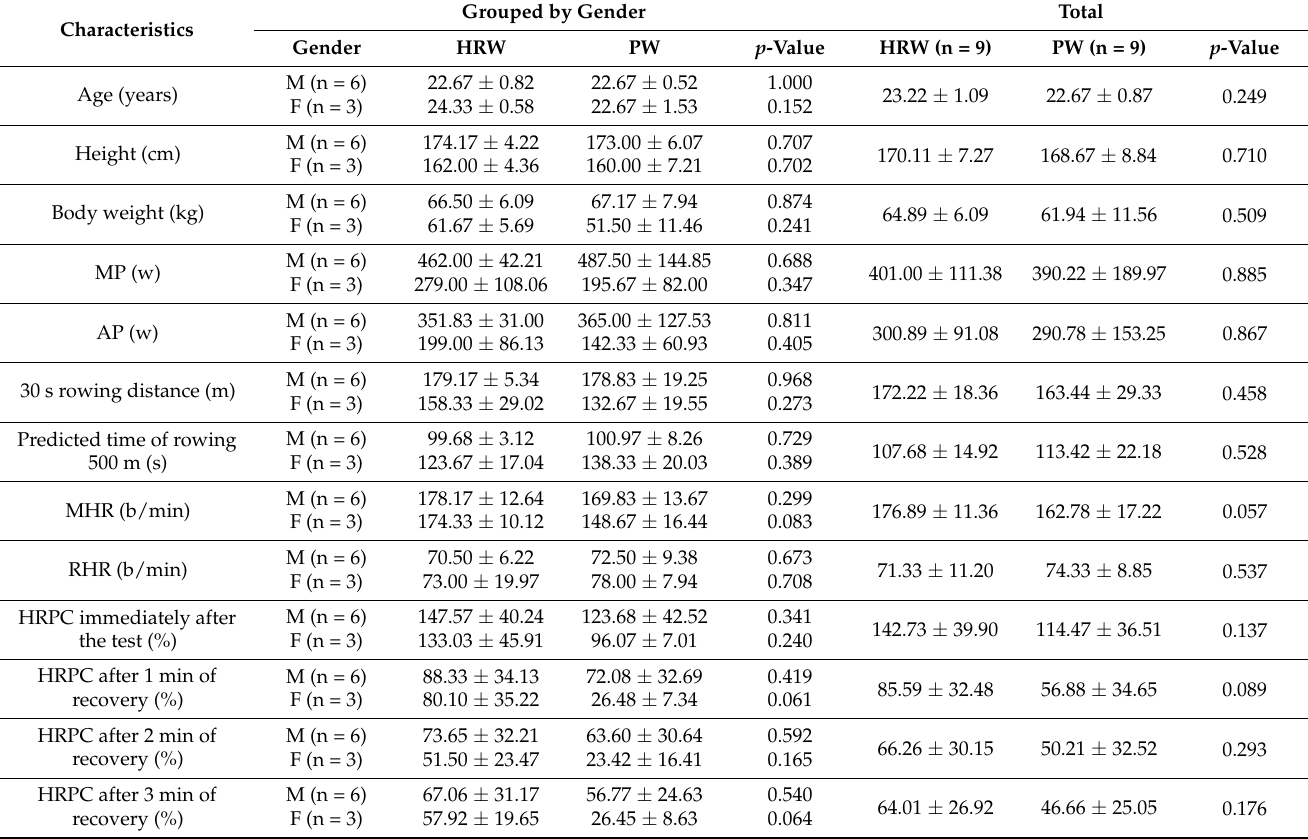
Table 1. Baseline characteristics of